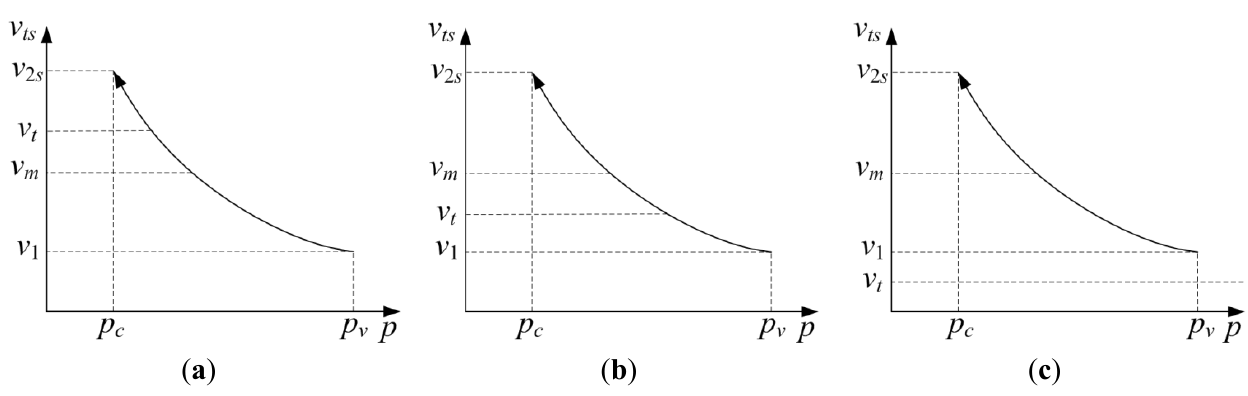
Figure 2. Three categories of the expansion process: ( a ) Category A; ( b ) Category B; and ( c ) Category C.